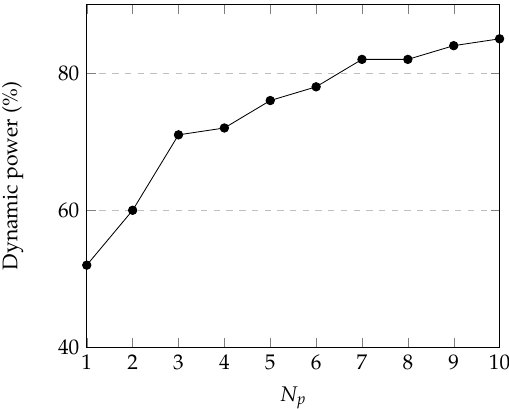
Figure 19. Power estimates for different N p .